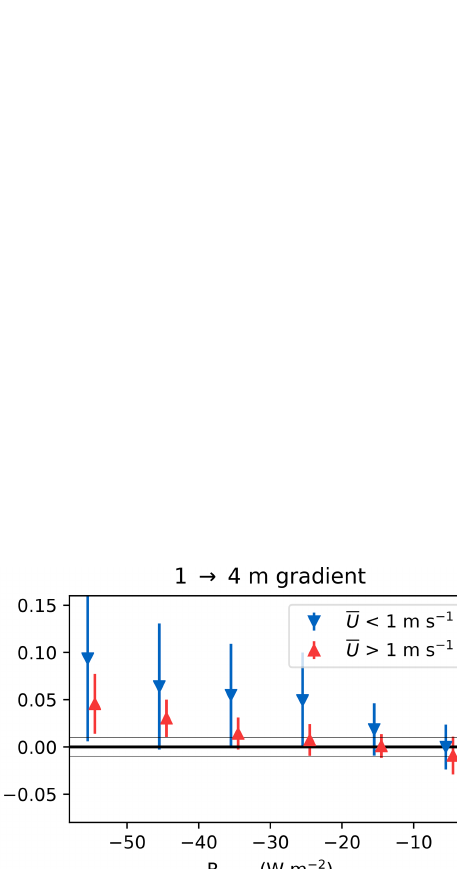
Figure B4. Error in the DTS-measured gradient between 1 and 4m. Data are binned by the net longwave radiation and split into 1m wind speeds under 1ms − 1 (blue, n = 207) and over 1ms − 1 (red, n = 544). Gray lines indicate ± 0.01K. Error bars show ± 1 standard